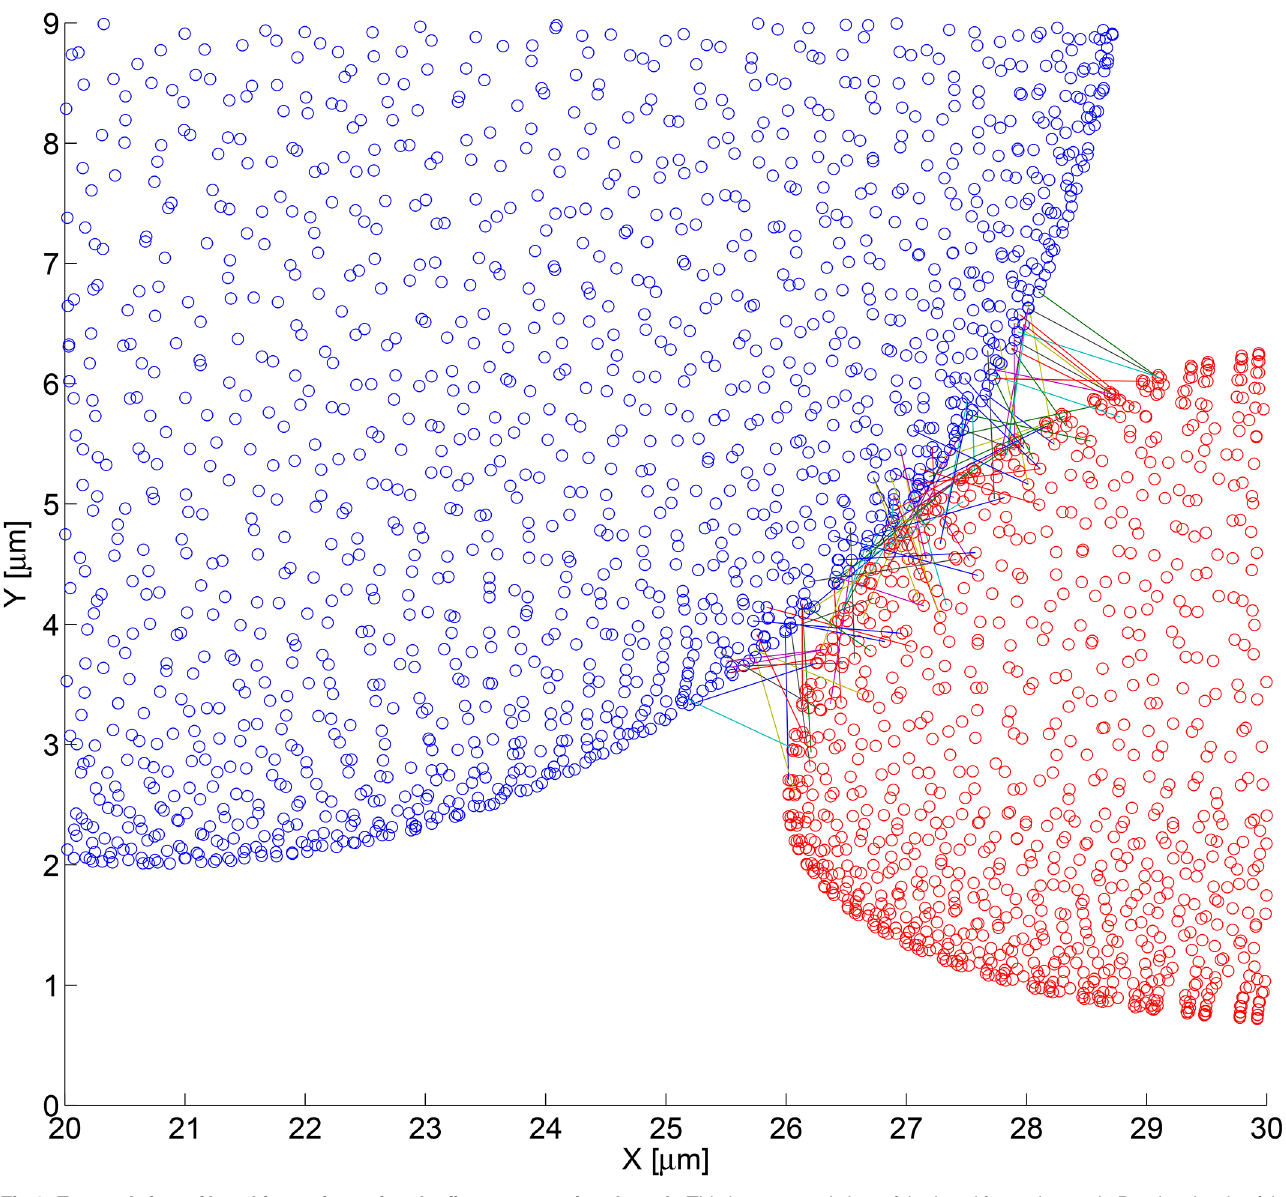
Fig 6. Zoomed view of bond formation using the fine computational mesh. This is a zoomed view of the bond formation and 3D point clouds of the PMN and melanoma cell using the fine mesh (shown in Fig 5). A total of 96 bonds were formed and are shown. Note: multiple bonds may occur between the same face